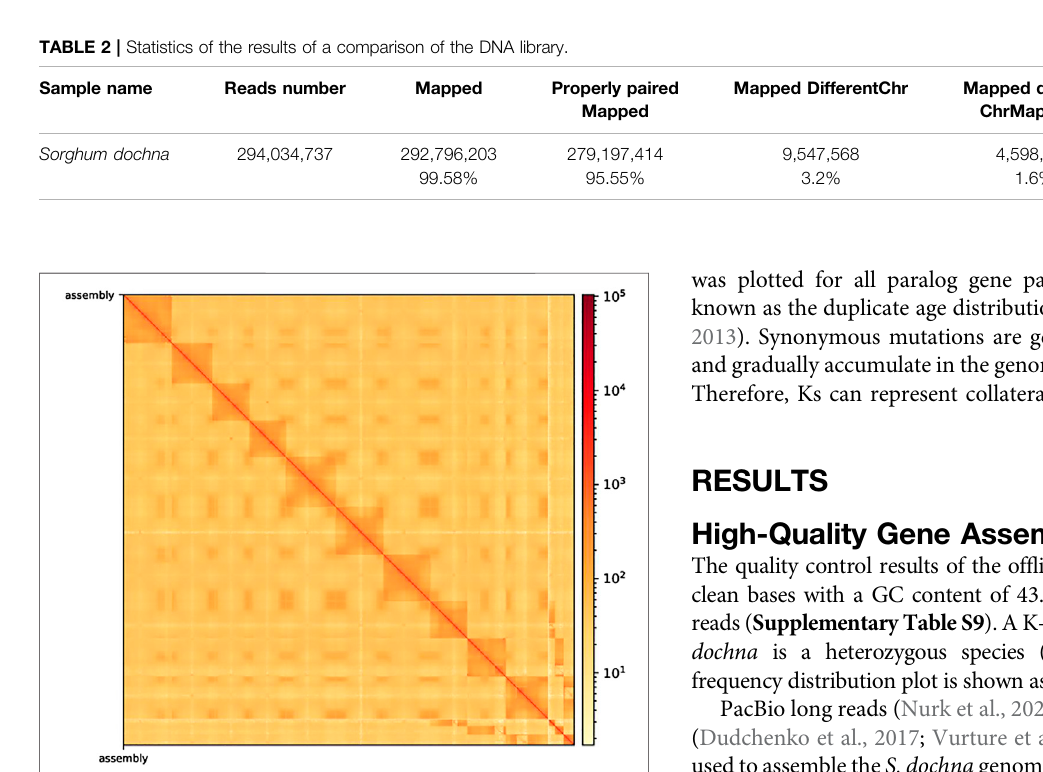
FIGURE 2 | Hi-C-assisted assembly genome interaction heatmap. The exchange within chromosomes is stronger than that between chromosomes. Moreover, the exchange between the same chromosomes with a close physical location is stronger than the exchange between chromosomes with a distant physical location. Hi-C, high-throughput chromosome capture